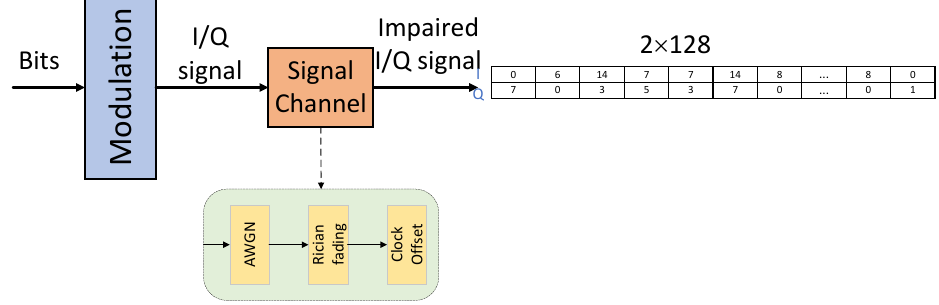
Figure 7. Dataset Generation